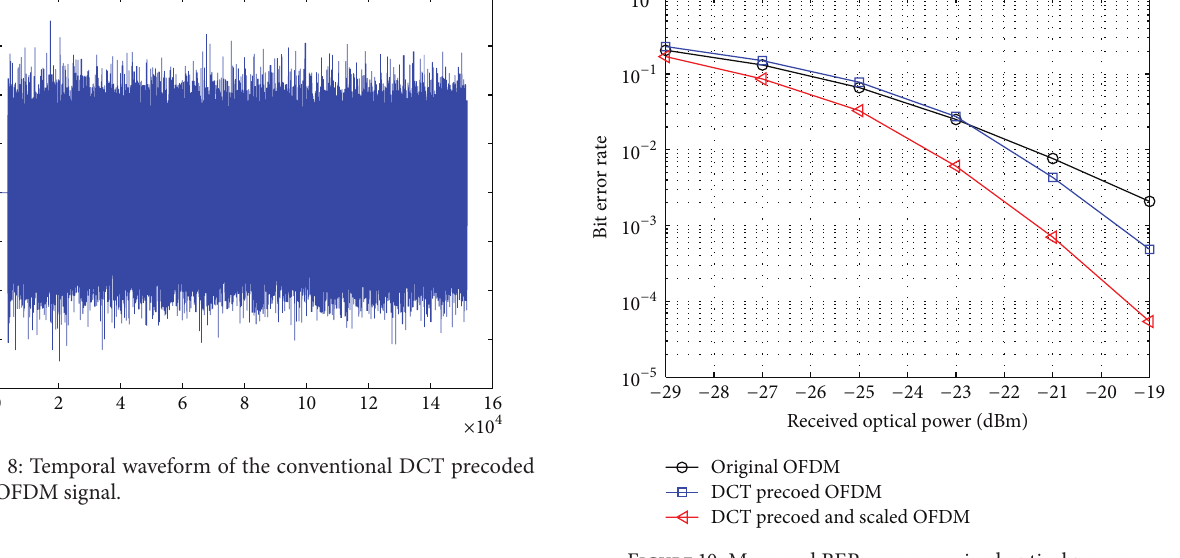
Figure 10: Measured BER versus received optical power.